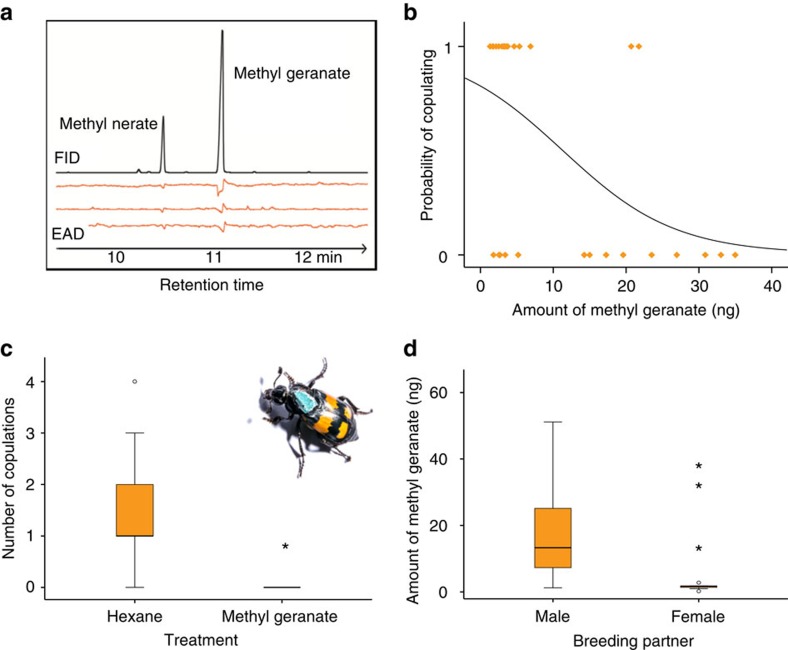
Function of methyl geranate as an anti-aphrodisiac.(a) GC-EAD chromatogram of synthetic methyl geranate using antennae of male N. vespilloides. All three male antennae responded to methyl geranate, and to methyl nerate that occurred as a byproduct in the sample. (b) The link between methyl geranate quantities released by females over a period 20 min and male copulation probability. Symbols represent original data. Curve represents the calculated logistic regression. N=31, Wald-=6.41, P=0.01. (c) Number of copulations per female. Females were equipped with a septum (see picture) that was either treated with a methyl geranate solution or pure hexane (control). Boxplots show median, interquartile range, minimum/maximum range excluding outliers, outliers (circle, >1.5 × interquartile range) and extreme outliers (asterisks, >3 × interquartile range). N=27, Poisson GLM: Wald-=9.2, P=0.002. Image of the beetle reproduced with permission from the author, Kai Schillinger. (d) Amount of methyl geranate emitted by females over a period of 20 min breeding with a male or a female partner. Boxplot conventions as in (c). N=28, Gaussian GLM: F1,26= 5.78; P=0.02.